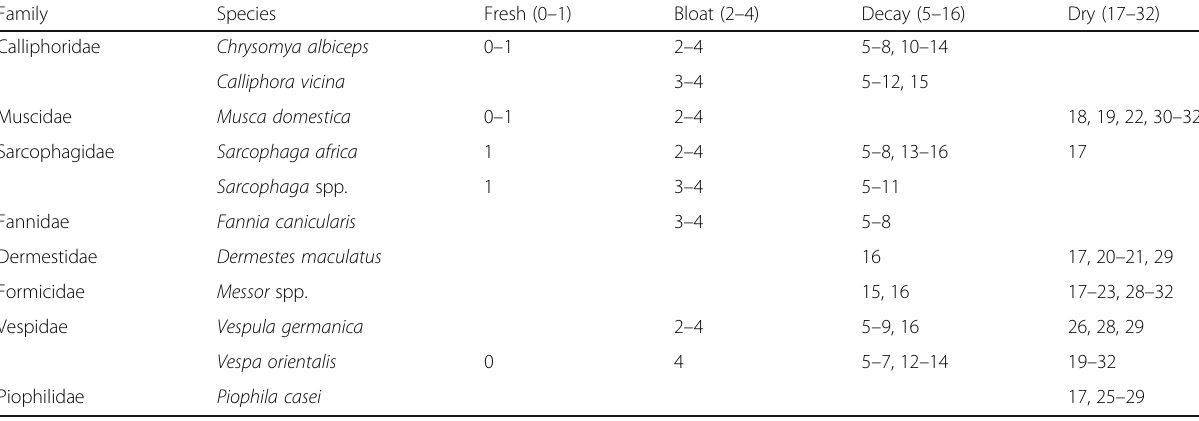
Table 1 Insect succession in the outdoor habitat Mamasani city, Iran